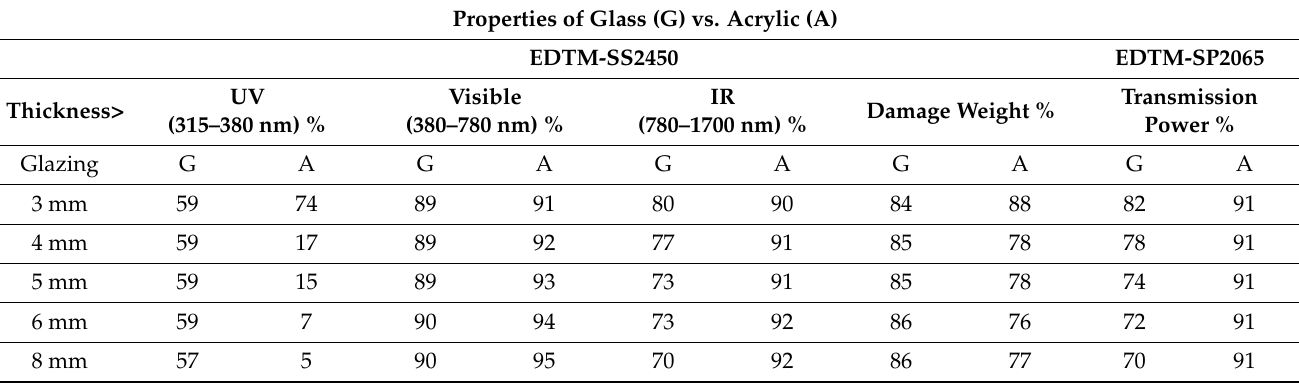
Table 2. Comparison between glass and acrylic samples’